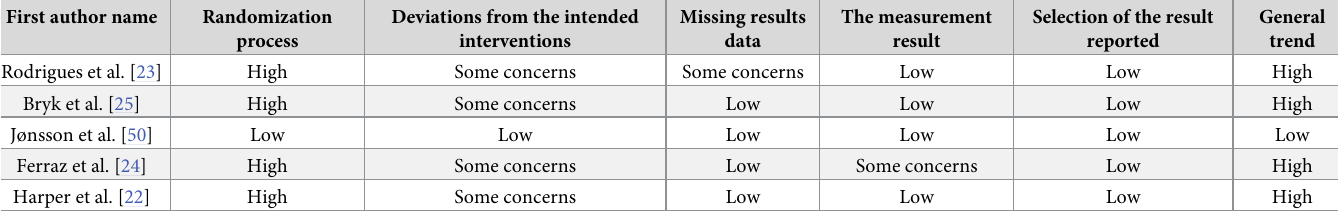
Table 5. Methodological quality of the studies using the tool RoB